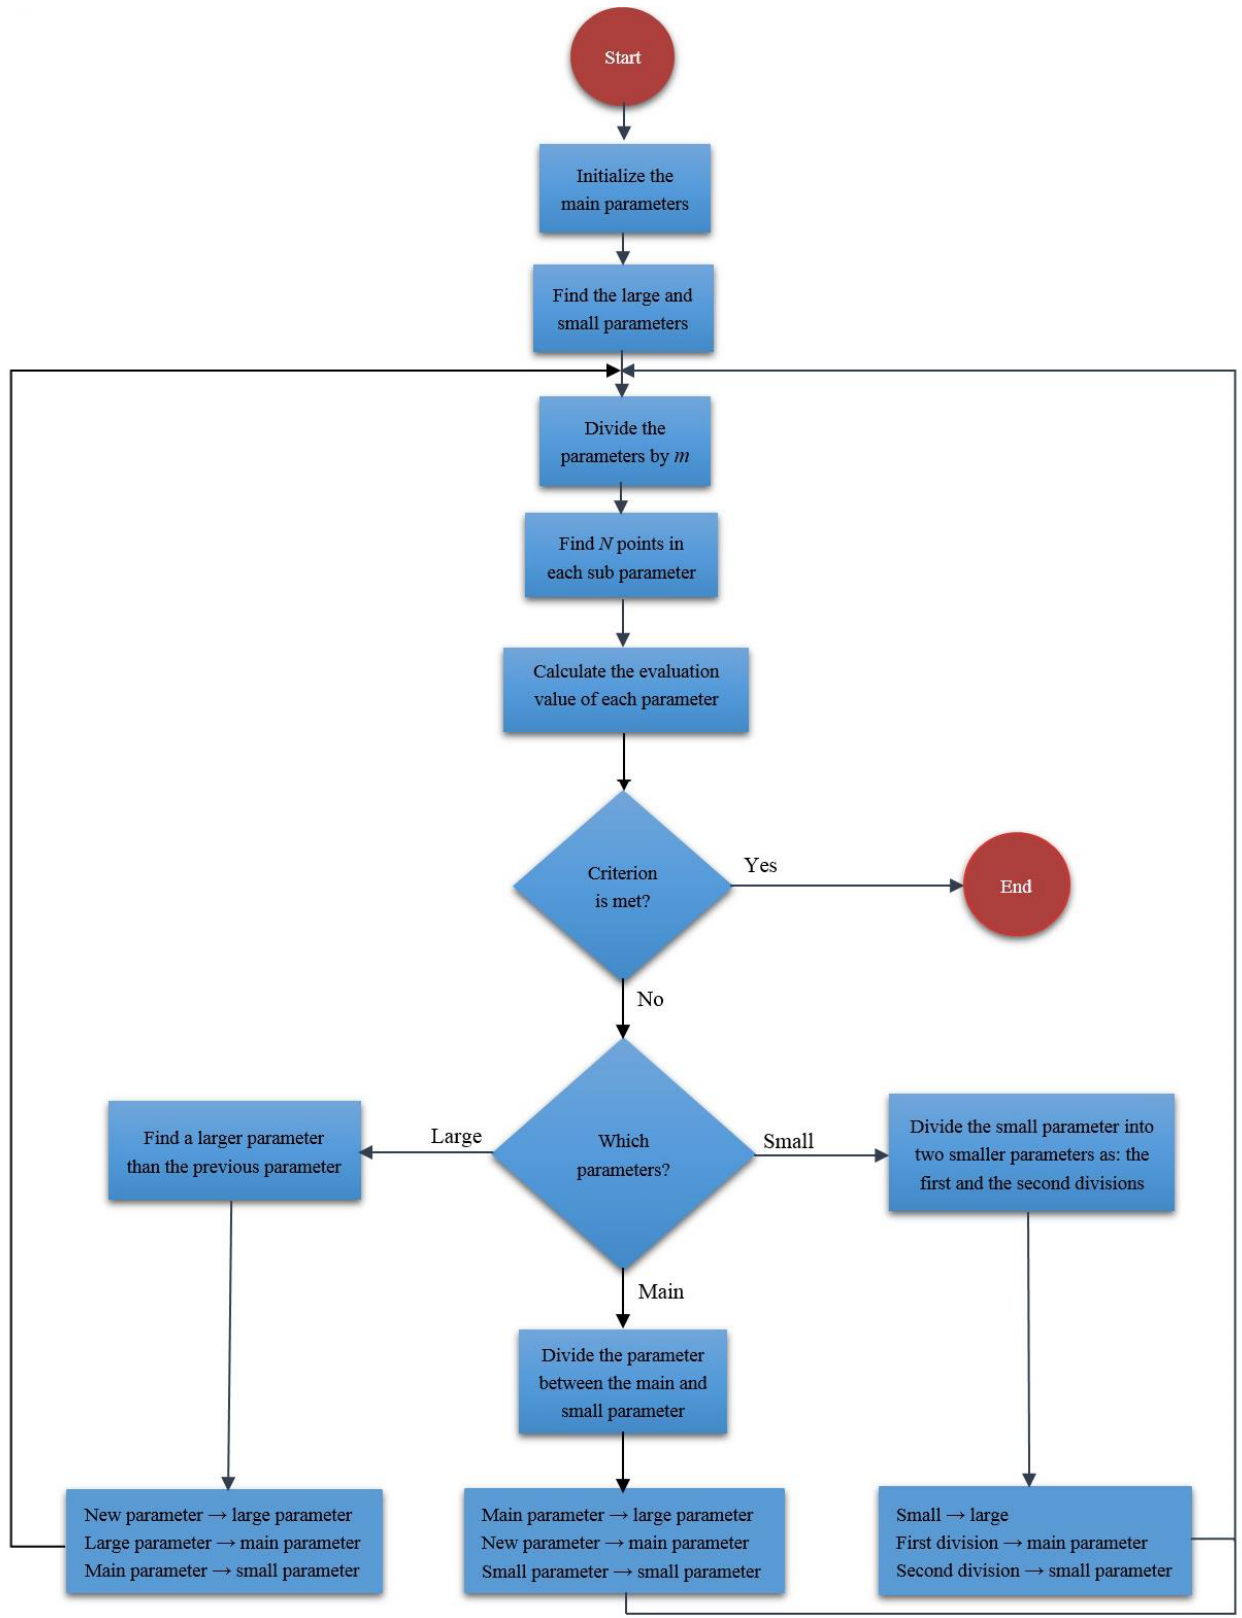
Figure 3. The implementation process of the division algorithm used in the current study [26]. With permission